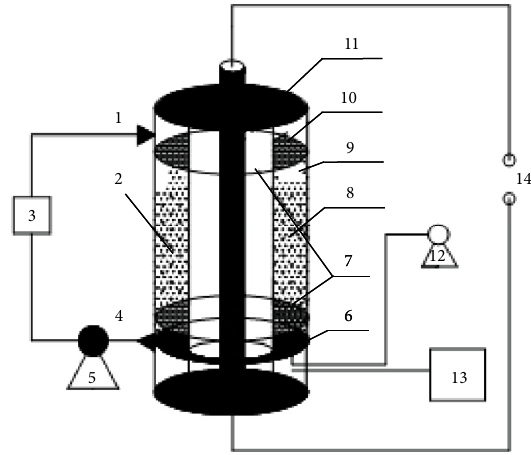
Figure 1: Schematic diagram of annular BFBPR. ((1) Sample solution inlet; (2) Catalyst particles; (3) Sample reservoir; (4) Sample solution outlet; (5) Solution circulation pump; (6) Pipe- type gas distributor; (7) Nylon mesh; (8) Reaction pool; (9) Synthetic glass tube; (10) Pyrex glass tube; (11) UV-light; (12) Gas pump; (13) Sampling pore and pH Detector; (14) Electrical